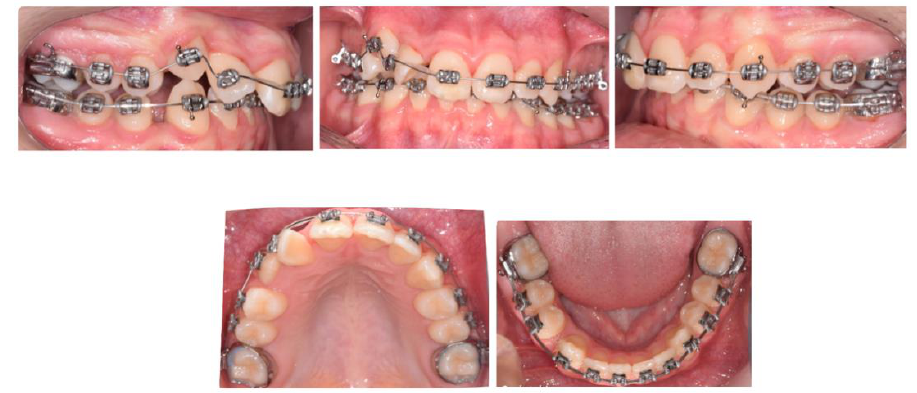
Figure 6. Fixed appliances and headgear were used to create sufficient space in the upper arch and align the teeth.